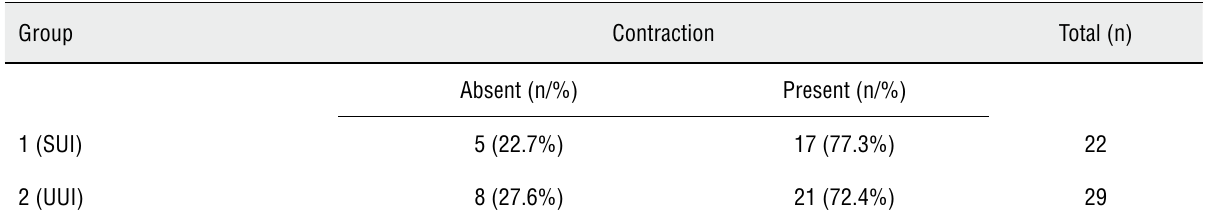
Table 3 - Visual analysis of perineal muscle contractions.